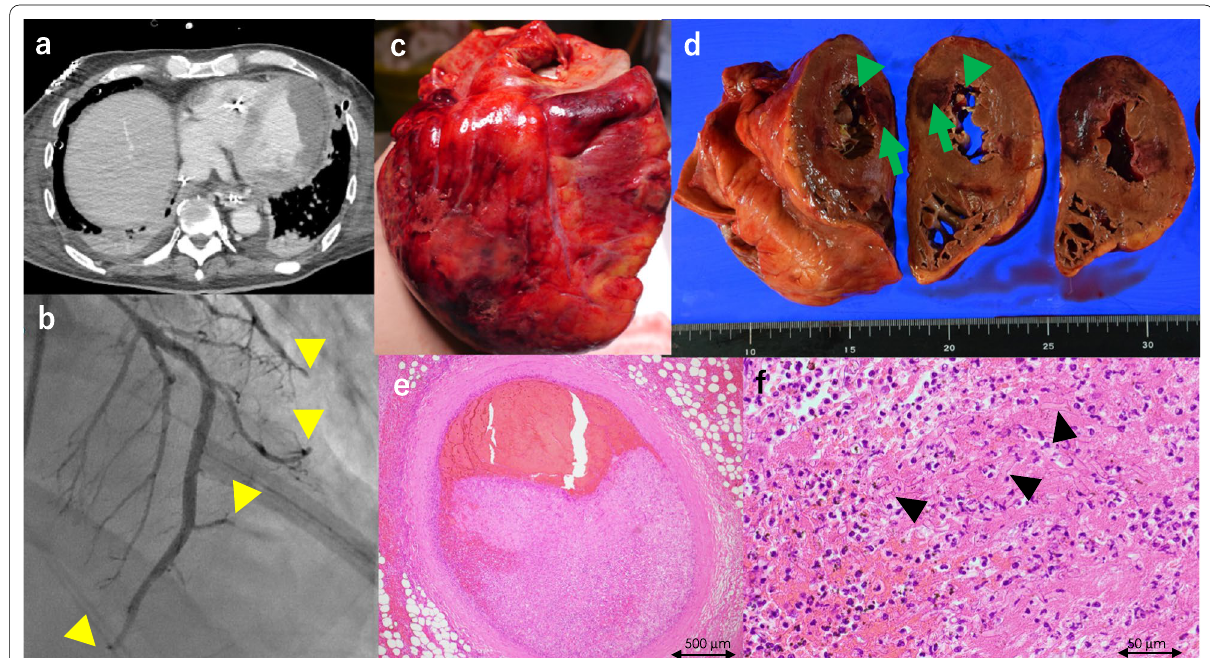
Fig. 3 Heart lesions. a Enhanced CT reveals an unenhanced area in the heart wall, suggesting multiple myocardial infarctions on POD 27. b Percutaneous cardiogram showing non-stenotic coronary arteries with multiple peripheral disruptions (yellow arrowheads). c – f Autopsy; multiple myocardial infarctions are penetrating the whole wall of the heart (green arrow). Vegetation is formed along with the chordae tendineae in the left ventricle ( d , green arrowheads). Coronary arteries are patent but filled with fungal thrombosis on the peripheral side ( e ). Fibrin-containing fungal hyphae (arrowheads) cover the endothelium in all chambers, indicating fungal endocarditis ( f ). CT computed tomography, POD postoperative